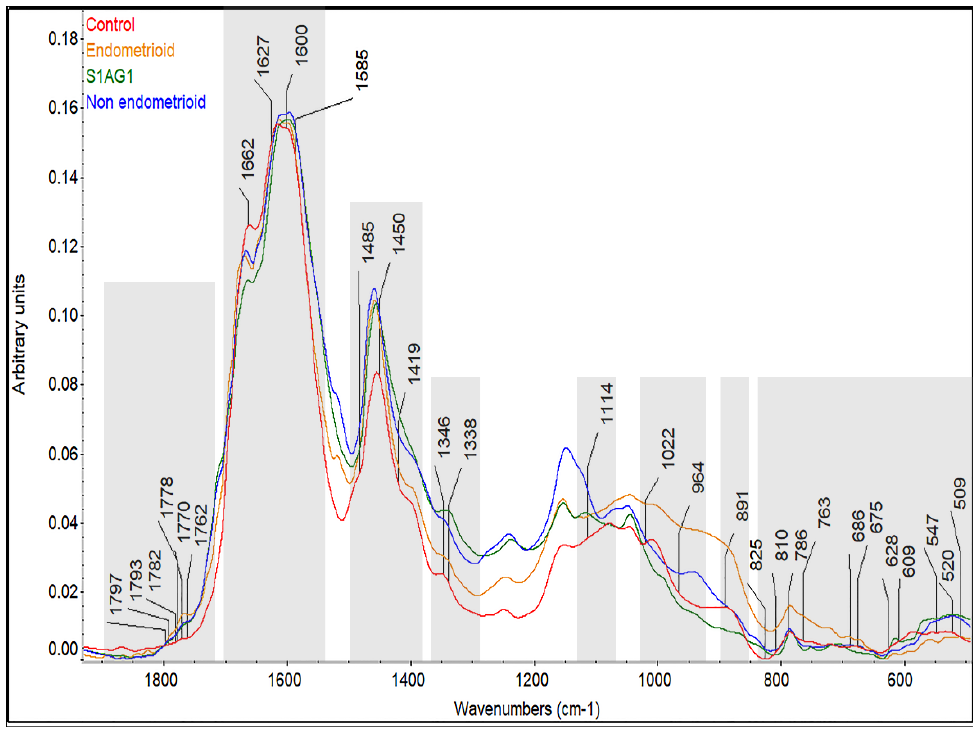
Figure 5. Average spectra of the studied groups. The figure depicts the fingerprint region (1800–500 cm − 1 ) and the prospective spectral biomarks who are responsible for the discrimination between the analysed groups. The shaded regions indicate where the prospective biomarks are found, marking potential regions for endometrial cancer diagnostic.